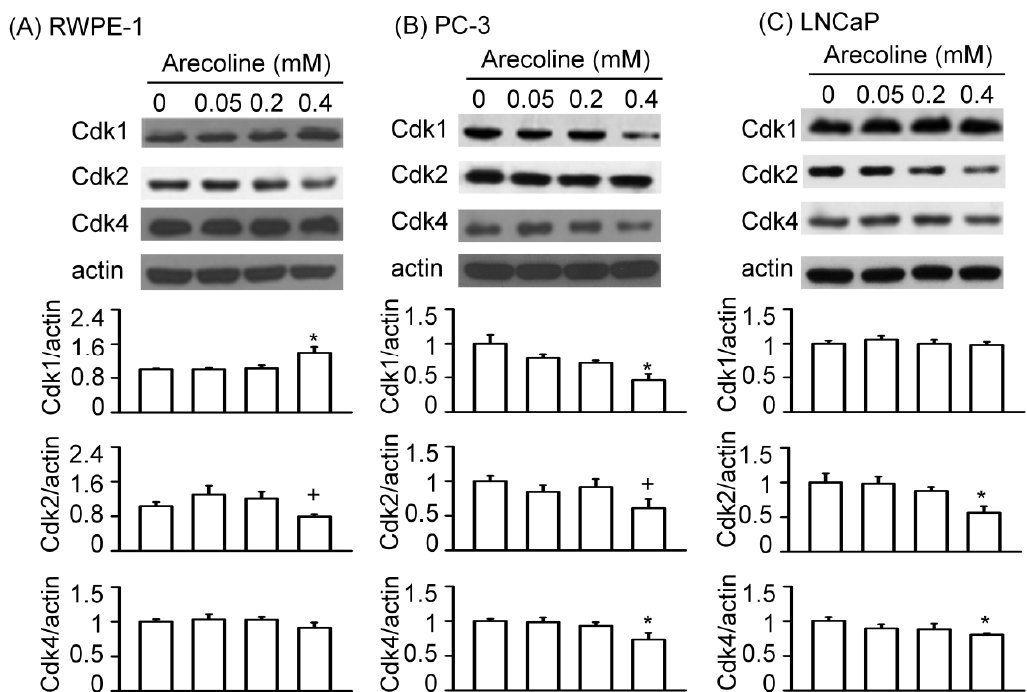
Figure 3. Differential effects of arecoline on proteins in the cyclin-dependent kinase (CDK) family between normal RWPE-1 ( A ) and cancerous PC-3 ( B ) and LNCaP ( C ) prostate cells after 24 h of treatment. Data are expressed as the mean ± SEM from triplicate experiments after Western blot analysis; each result was pooled from the data of four 10 cm culture plates. * p < 0.05 vs. the control. + p < 0.10 vs. the control.